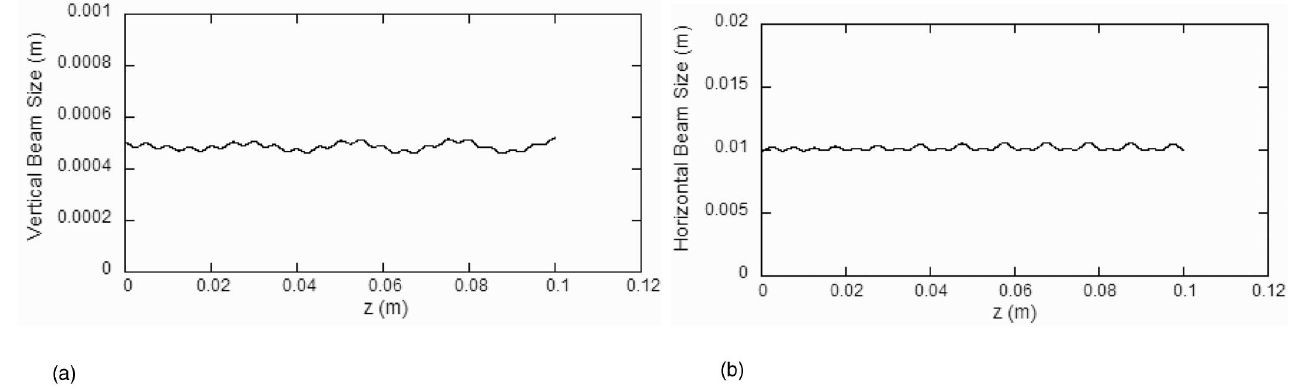
FIG. 4. Nominal two-plane focusing case for wiggler focusing, with peak field of 0.263 T and a wave number ratio of 0.14. (a) Vertical beam size versus axial position. (b) Horizontal beam size versus axial position.